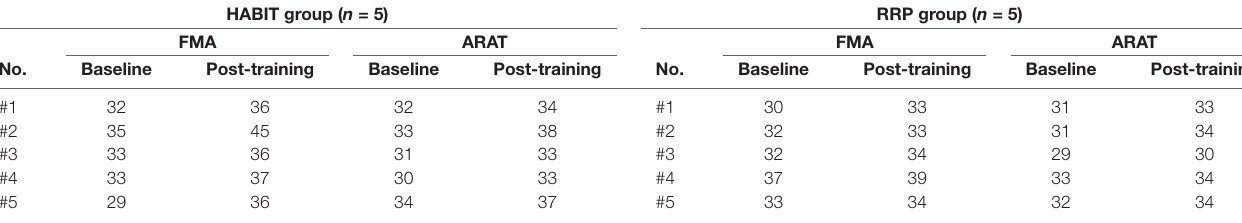
TABLE 4 | Clinical validation of HABIT on patients with acute